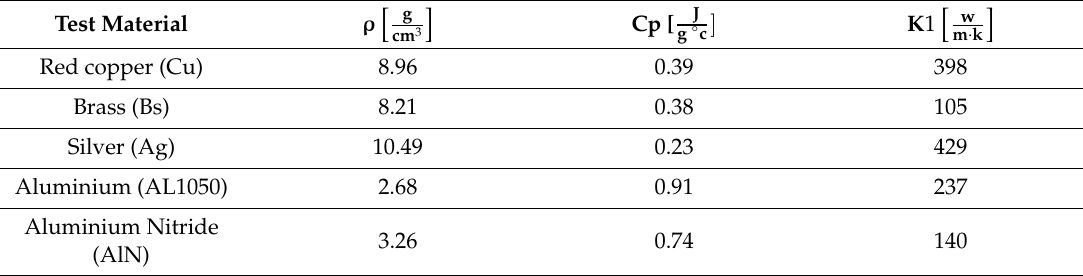
Figure 7. The experimental results of the five materials: ( a ) Red copper (Cu); ( b ) Brass (Bs); ( c ) Silver (Ag); ( d ) Aluminium (AL1050); ( e ) Aluminium Nitride (AlN). Table 1. Physical properties of the